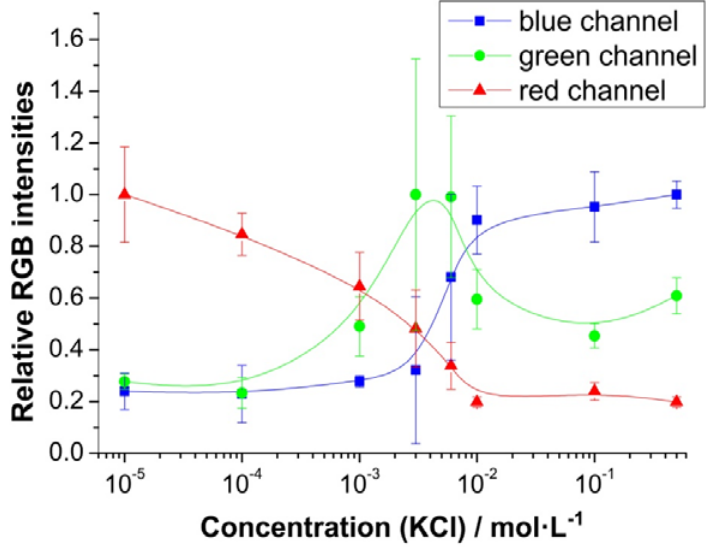
Figure 5. Relative intensities of the blue, green and red channel of a digital picture of a sensor layer immersed in solutions of KCl in varying concentrations. Pictures were acquired with a camera mounted on a microscope with 50-fold magnification. Each data point presents the average of five measurements. The error bars give standard